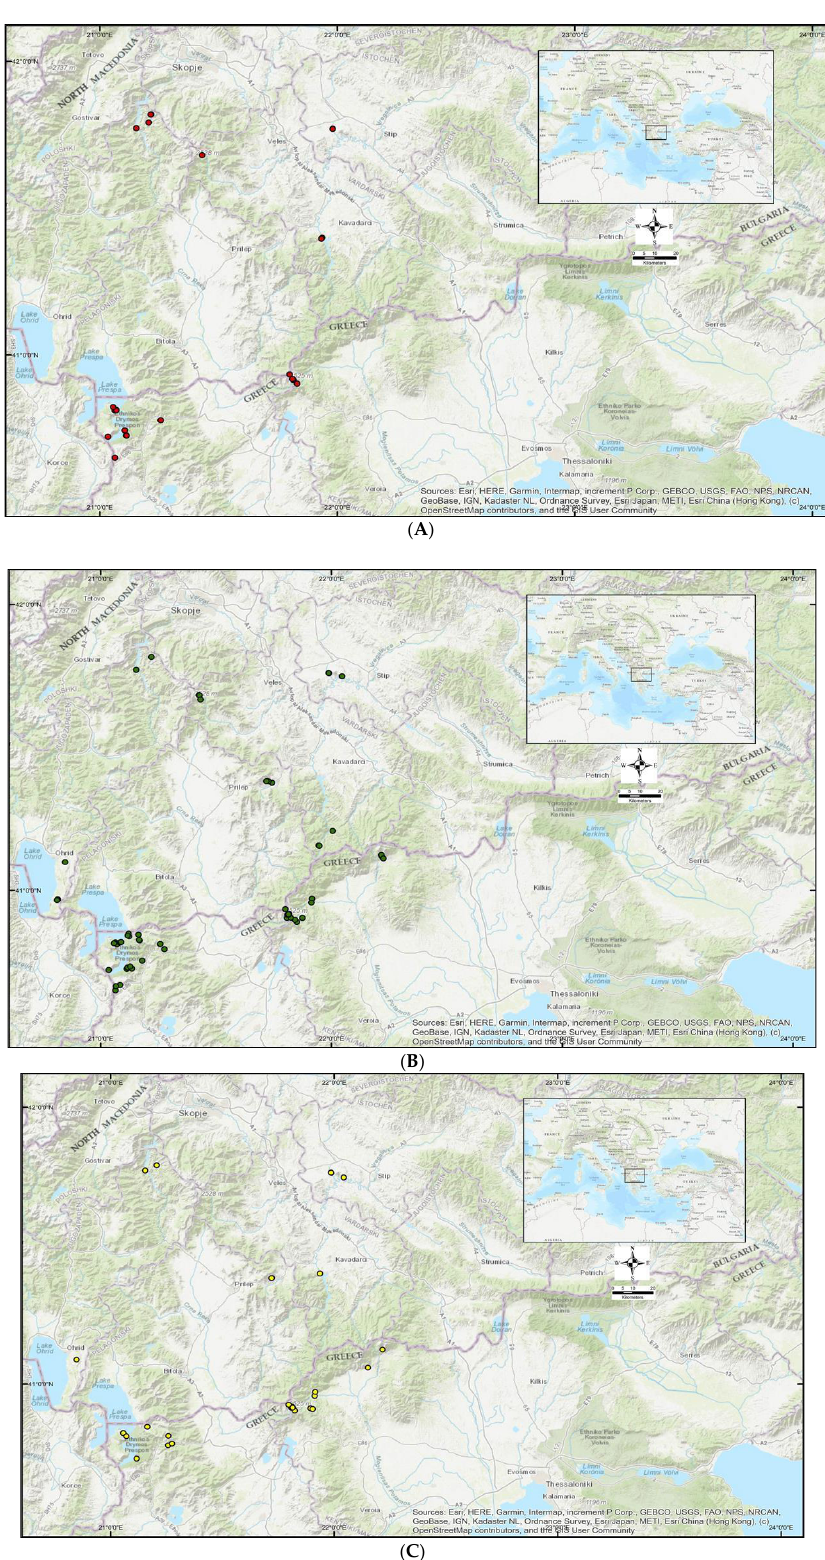
Figure 1. Botanical collections performed in Greece and the Republic of North Macedonia of plants of different conservation priority categories. ( A ) PCA, Threatened and Near Threatened (red dots); ( B ) PCB, Local Balkan endemics and subendemics (green dots); ( C ) PCC, Regionally rare and/or uncommon plants (yellow dots).